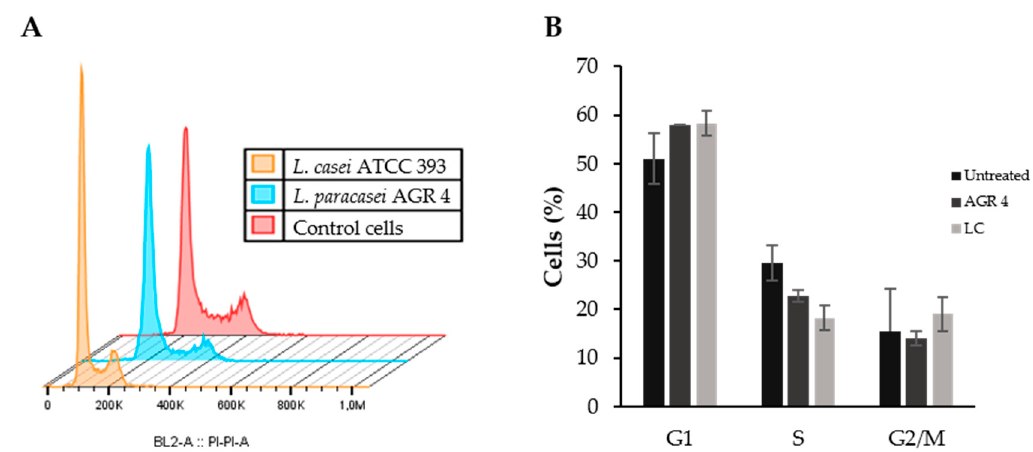
Figure 7. Assessment of the effect of L. paracasei AGR 4 in HT-29 cell cycle progression via flow cytometry. HT-29 cells were incubated with L. paracasei AGR 4 or L. casei ATCC 393 (LC) at a density of 10 7 CFU / mL for 48 h. Cells treated with sterile culture media were used as a control. ( A ) Representative flow cytometry plot. ( B ) Quantitative analysis of two independent experiments.